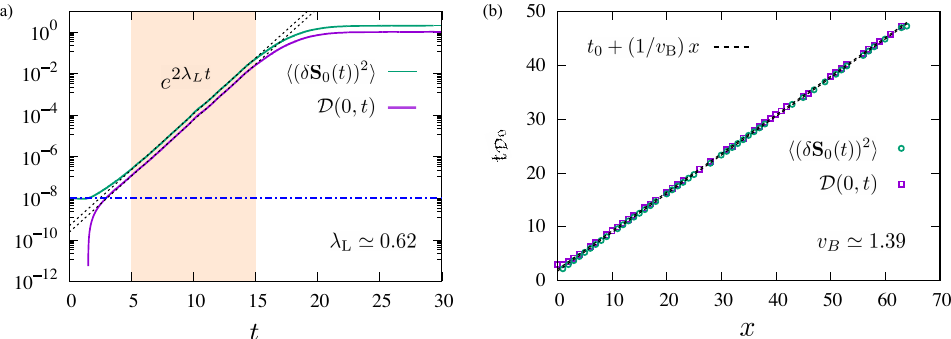
Figure 13: Decorrelation and trajectory difference: Comparison of decorrelation function D ( x , t ) and trajectory difference ( 〈 δ S exponent and (b) butterfly velocity at temperature T = 2.0 for easy plane anistropy ( ∆ = 0.3). From the exponential growth regime (shaded) in (a) we get same λ (cid:39) 0.62 and from inverse of the slope in (b) we found same v L quantities.